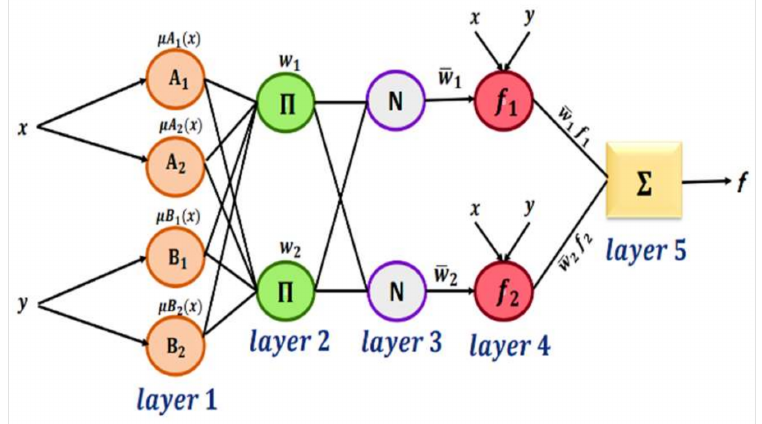
Figure 2. The structure of